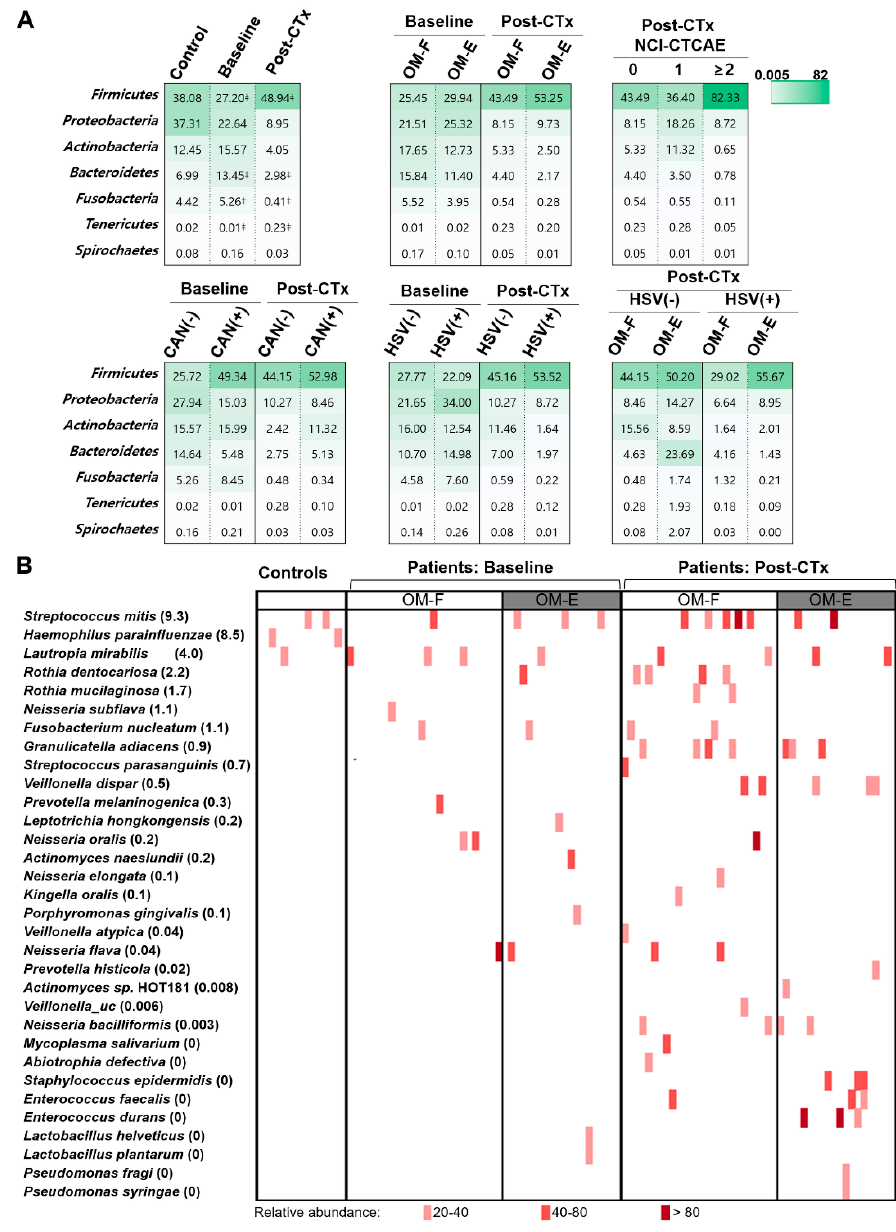
Figure 3. Composition of the mucosal bacterial communities collected from control subjects and patients undergoing autologous HSCT at baseline and post-chemotherapy (post-CTx). ( A ) The relative abundances of major phyla (average relative abundance > 1%) are expressed as a heat map. The value in each box presents the median. ‡ indicates a pair with a significant difference ( p < 0.05) by the Wilcoxon rank-sum test. ( B ) Species with a relative abundance > 20% in any sample were chosen and presented as a heat map. The number inside parentheses next to the name of the species indicates a median value for the relative abundance in the control group.